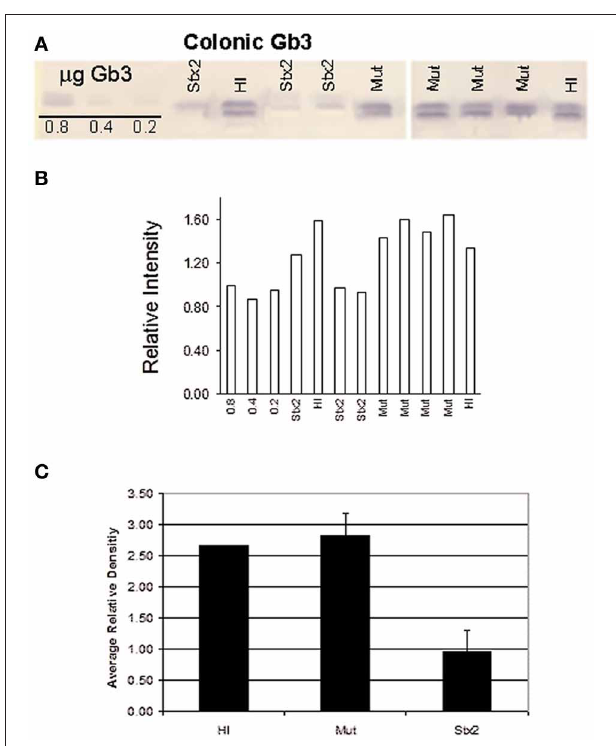
FIGURE 5 | (A) Thin layer chromatography of extracted lipids from the distal colon tissue of 2 HI, 4 Mut-, and 3 Stx2-treated infant rabbits. Gb 3 was detected using a Shiga toxin 1 B-subunit overlay method (Nutikka et al., 2003). Standards of 0.8, 0.4, and 0.2 μ g Gb3 are shown on the far left of the TLC plate. (B) TLC band density for each sample was determined using ImageJ 1.38 × software (Rasband, 1997–2007). (C) Mean density values were plotted for each treatment group. Error bars represent the standard